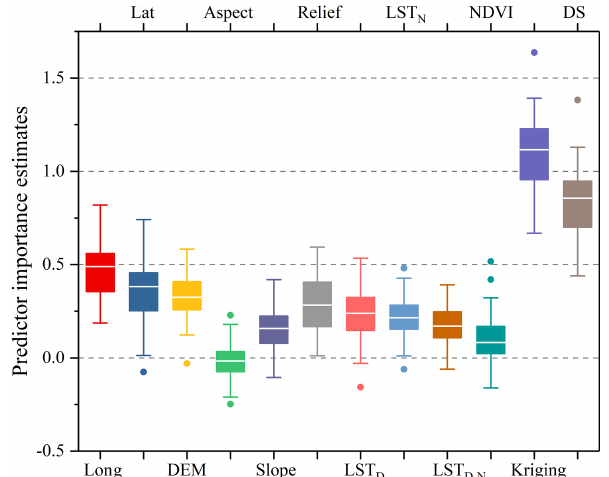
Figure 10. Predictor importance estimates (lat: latitude; long: lon- gitude; DS: downscaled